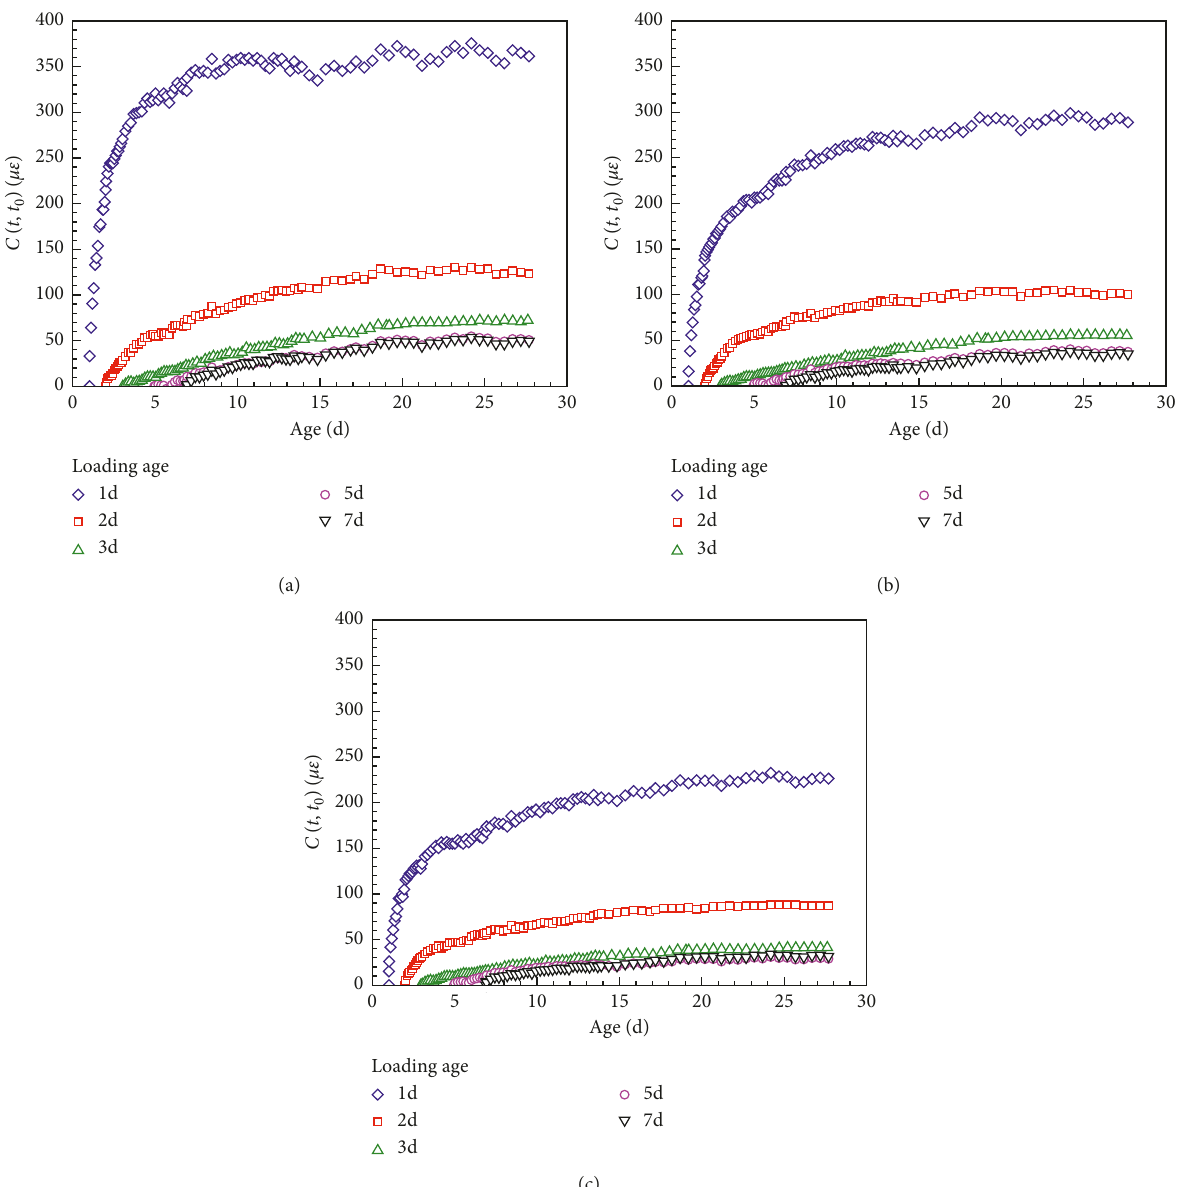
Figure 5: Specific creep of FA group at different loading ages. Stress/strength ratios: (a) 0.2, (b) 0.3, and (c)